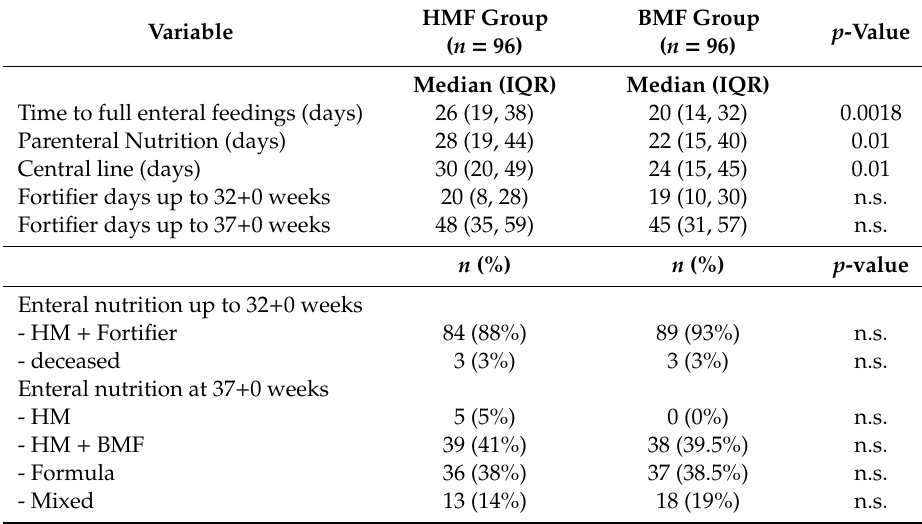
Table 4. Parameters of parenteral and enteral nutrition.